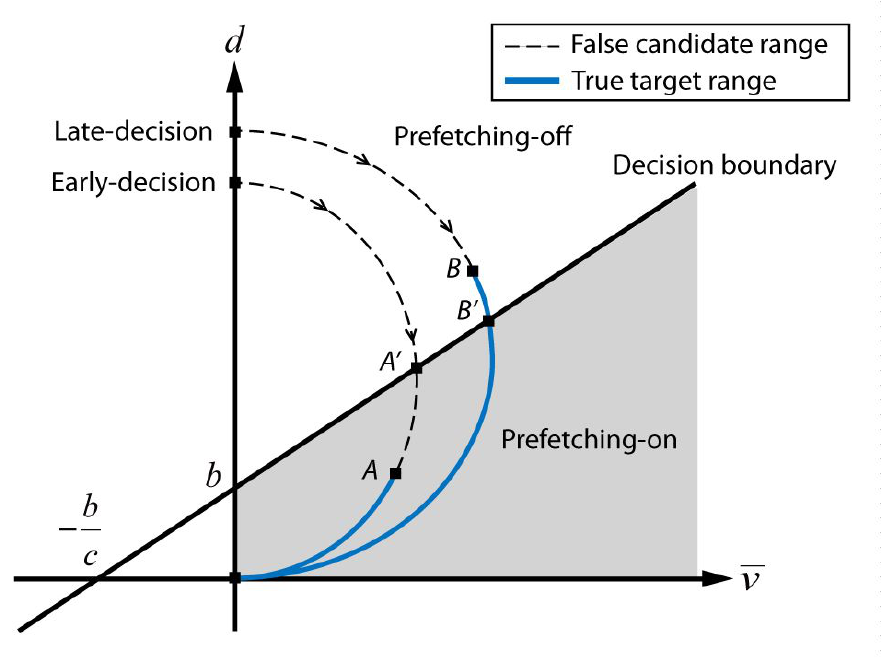
Figure 6. Typical target selections and decision boundary on the feature